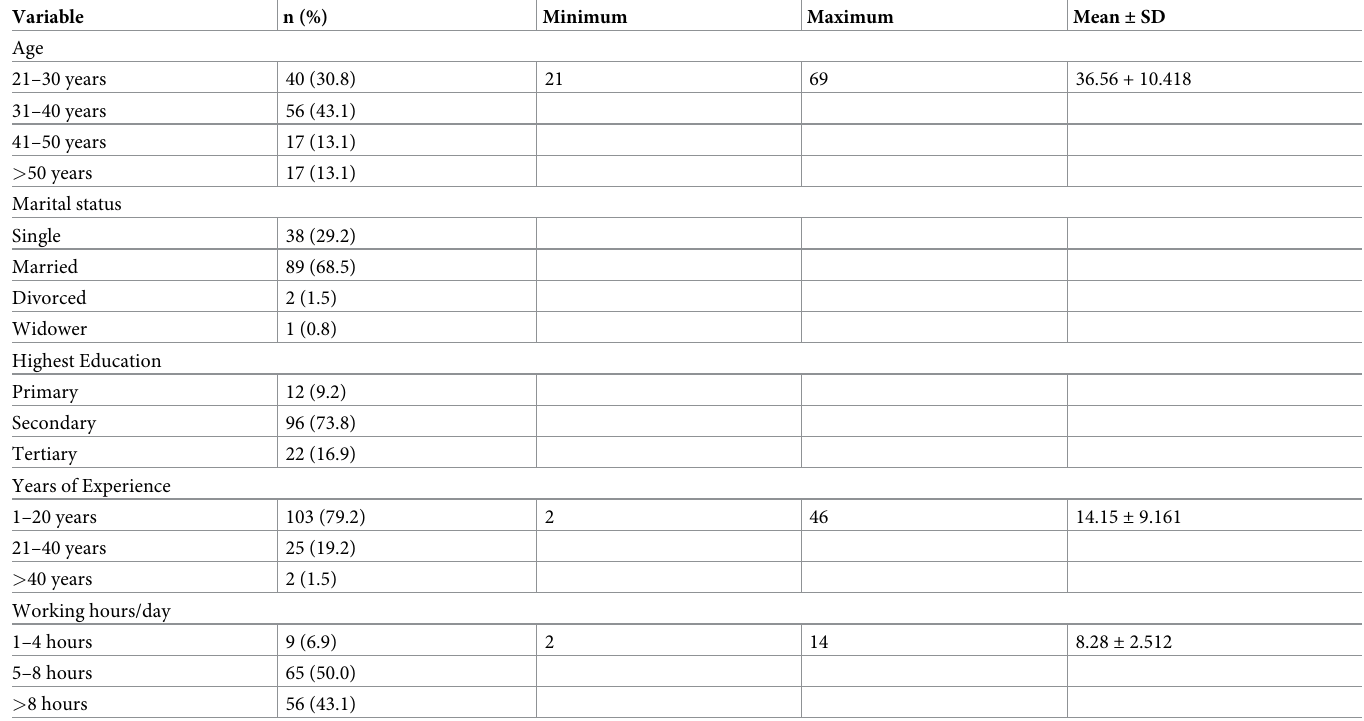
Table 1. Frequency distribution of respondents’ socio-demographic characteristics, years of experience and working hours per day (N =